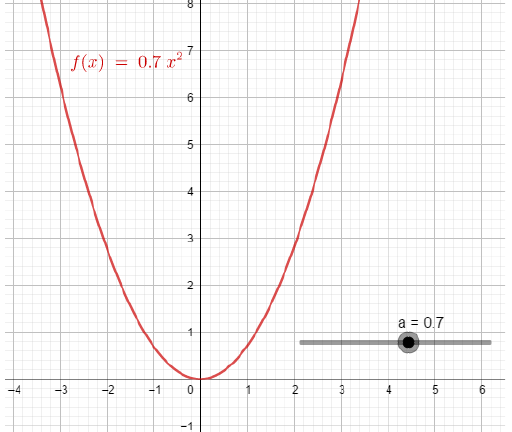
Figure 4. An example of a parabola and the quadratic function connected with a slider for parameter 𝑎 , represented in GeoGebra (our own construction).